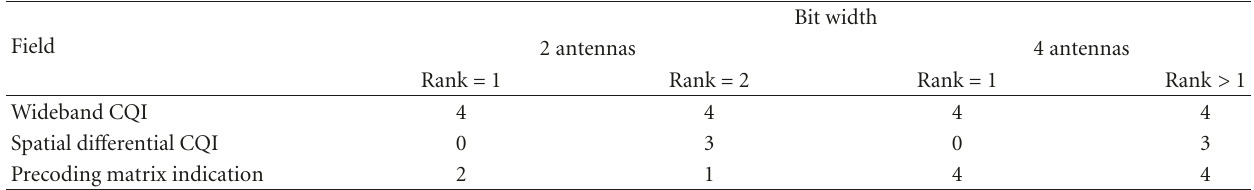
Table 9: Feedback of wideband CQI/PMI via